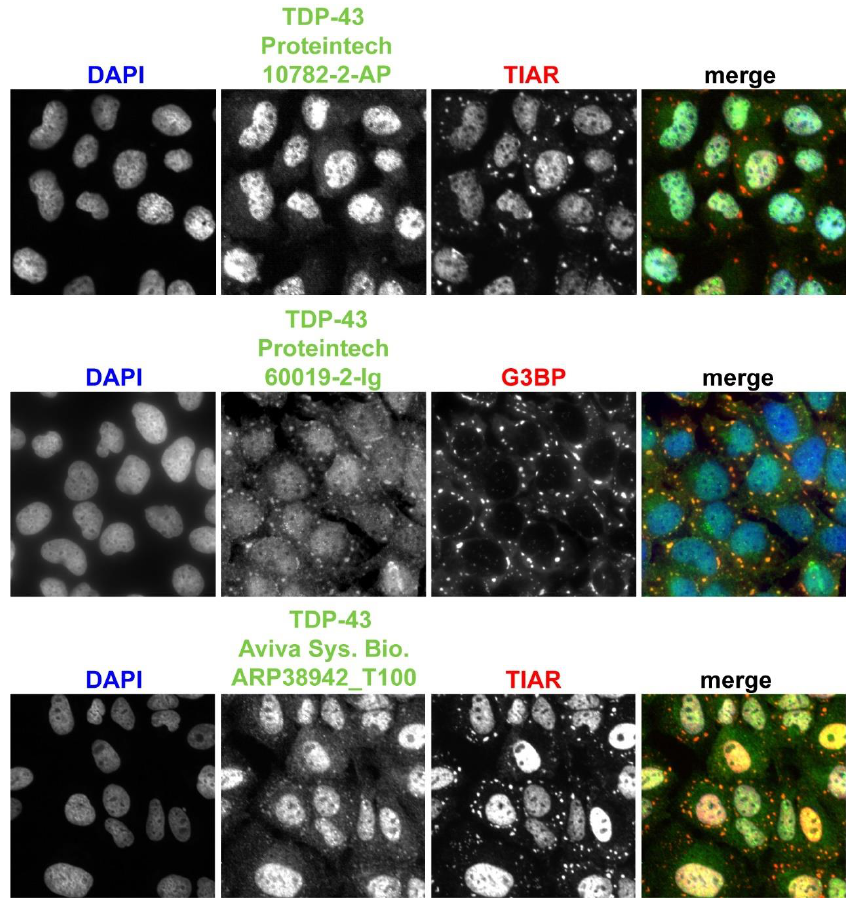
Figure 4. Detection of endogenous TDP-43 in arsenite-induced SGs varies in an antibody-dependent manner. ( A – D ). U2-OS (WT) cells were stressed with 0.5 mM sodium arsenite for 1 h followed by immunofluorescence and imaging with indicated TDP-43 antibodies. SG localization was verified with either TIAR or G3BP staining as indicated.